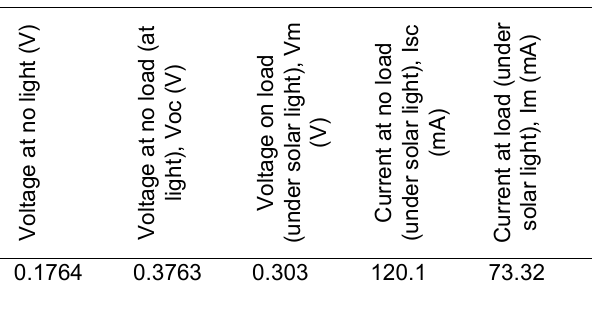
Table 4. Observations made for electrolyte sample B